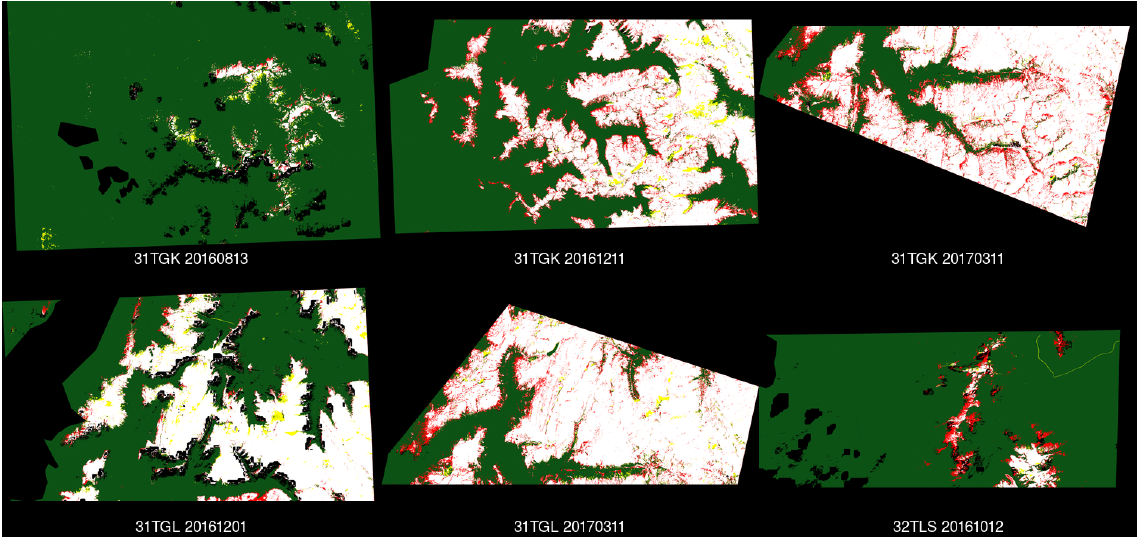
Figure A1. Theia snow products vs. SPOT-6/7 snow maps (green: true negative, white: true positive, red: false positive, yellow: false negative).